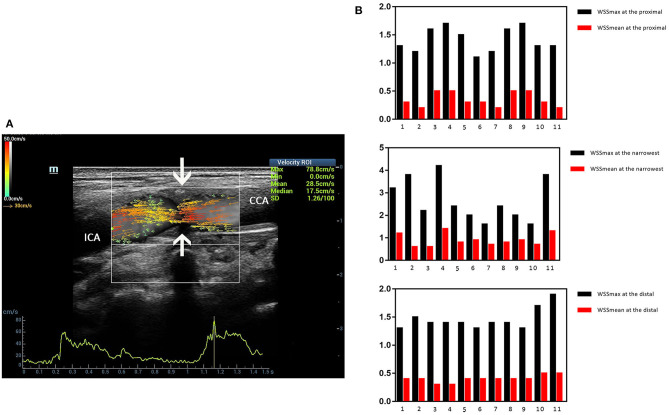
Mild carotid stenosis. V flow imaging shows high-velocity flow (red vectors) moving at the carotid stenosis(arrows) (A). Wall shear stress (WSS) point-by-point measurements at the proximal, distal, and narrowest regions had mean WSS (WSSmean) and maximum WSS (WSSmax) values showing in the figures. Abnormal low WSSmean values (<0.4 Pa) were detected at the proximal (0.2–0.3 Pa) and distal region (0.3 Pa) (B). CCA indicates common carotid artery; and ICA indicates internal carotid artery.